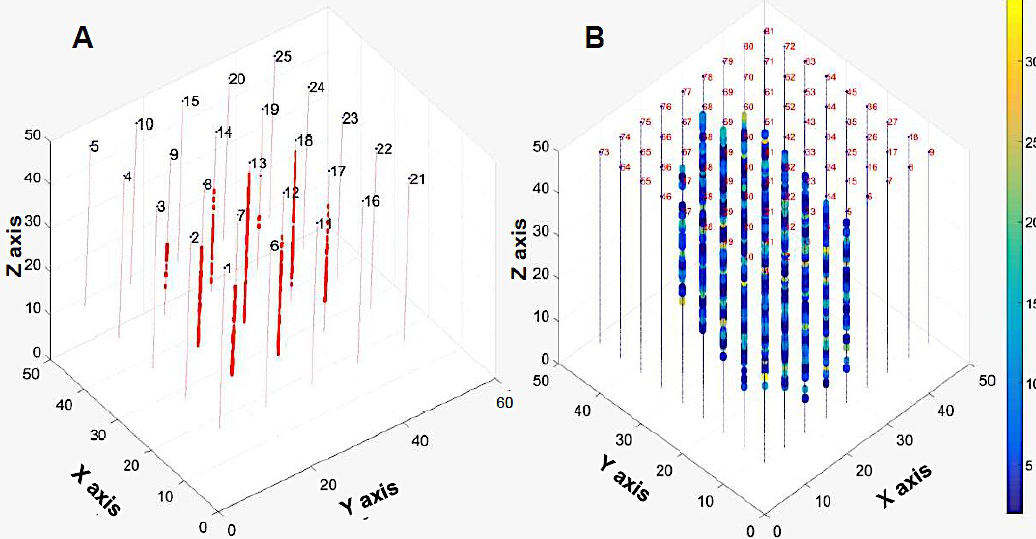
Figure 14. Simulated drill core samples. A (left)—25 (5 × 5) drill cores with thicker composites representing higher iron grade. B (right)—81 (9 × 9) drill cores of the synthetic ore body with thicker composites representing higher magnetite grade and colourbar showing actinolite grade in %.